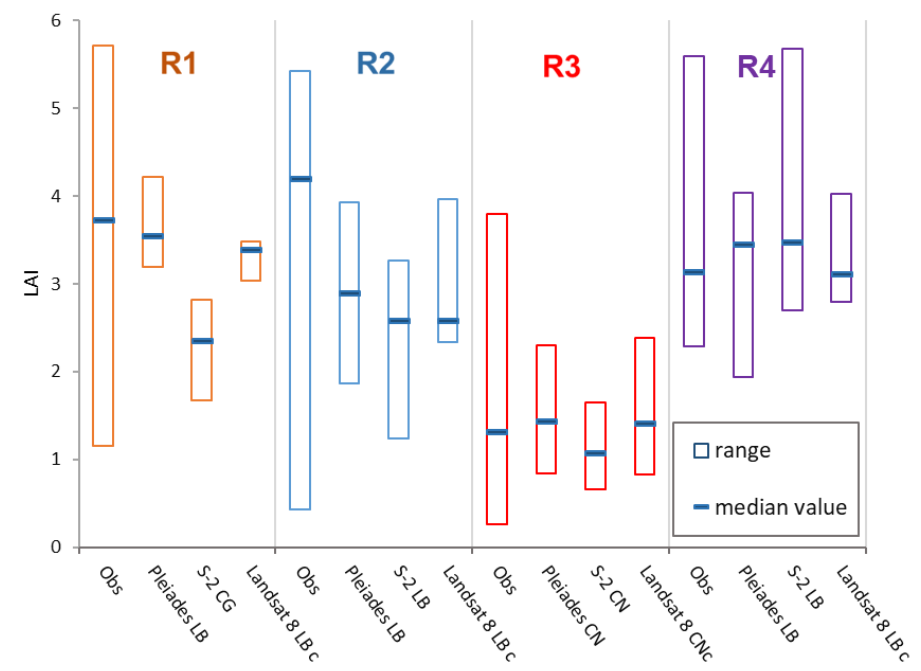
Figure 5. Ranges and median values of observed LAI (Obs) and LAI retrieved from remote sensing imagery in the Cammarota reaches.